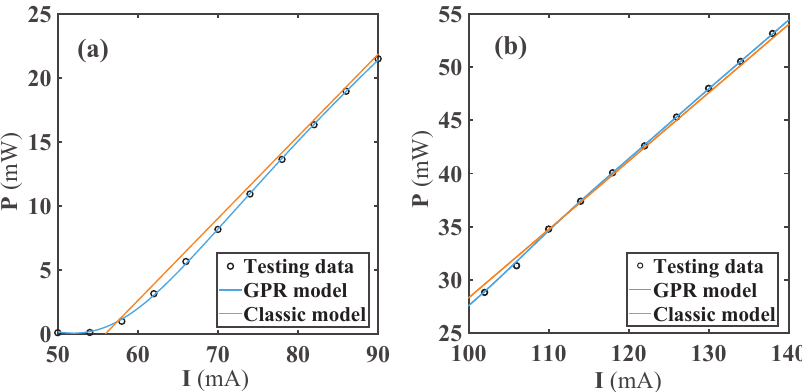
Figure 4. Comparison of the classic model and the GPR model for currents ranging from 50 mA to 140 mA. ( a ) Current ranging from 50 mA to 90 mA. ( b ) Current ranging from 100 mA to 140